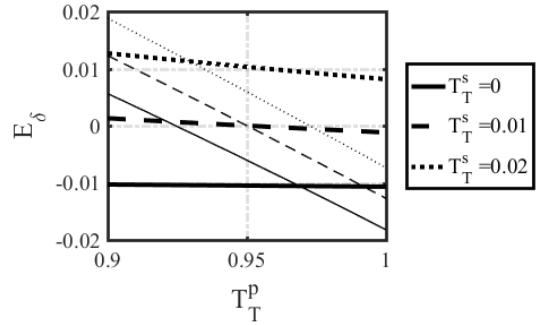
Figure 6. Simulated-to-real δ difference E δ over the parallel- polarized light transmittance T p for different perpendicular- T polarized transmittance T s . Thick and thin lines correspond to δ r T values of 0.004 and 0.45, respectively.